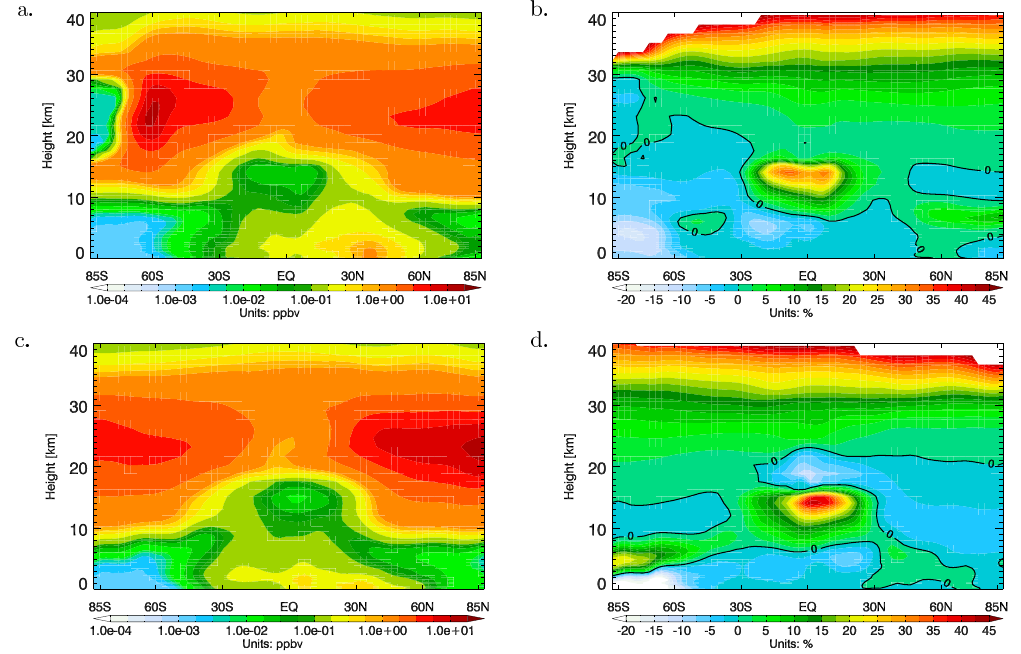
Fig. 2. The zonal mean HNO 3 mixing ratio in REF 2000, for July (a) and December (c) . Panels (b) and (d) show the percent change in mixing ratio from REF 2000 to R2 2000, for July and December, respectively.